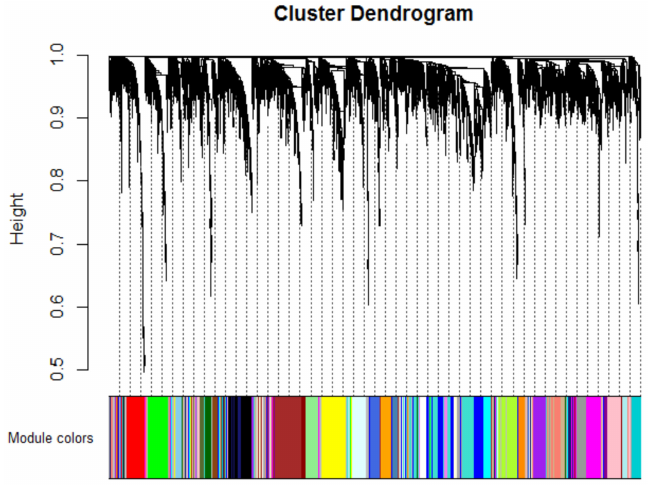
Figure 3. Dendrogram of all di ff erentially expressed genes clustered based on a dissimilarity